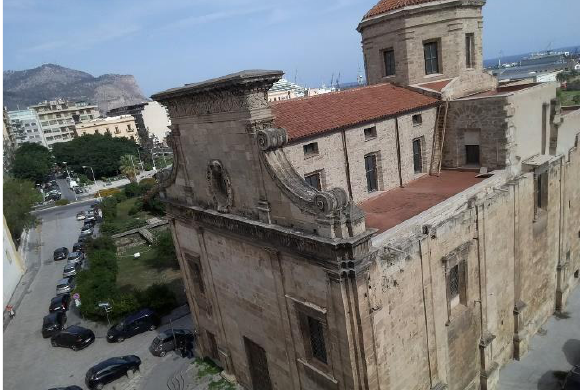
Figure 1. The church of San Giorgio dei Genovesi taken by the DJI Tello during survey operations.